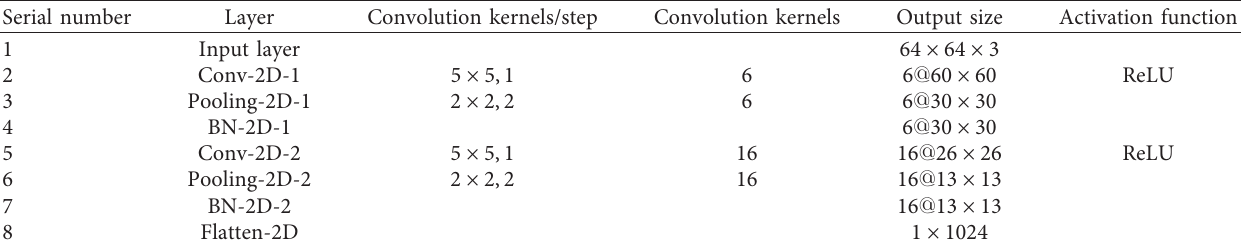
Table 2: 2D-CNN network parameter settings.